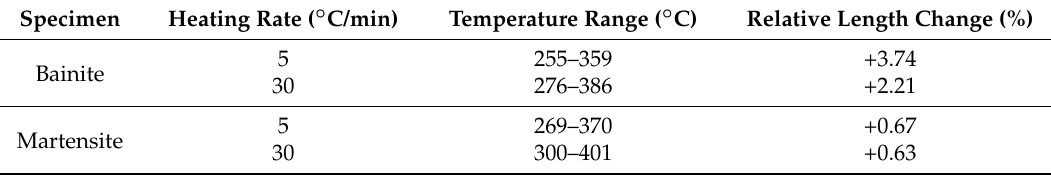
Table 2. Temperature interval of retained austenite decomposition and percentage of relative length change for maximum and minimum heating rates in both investigated microstructure.